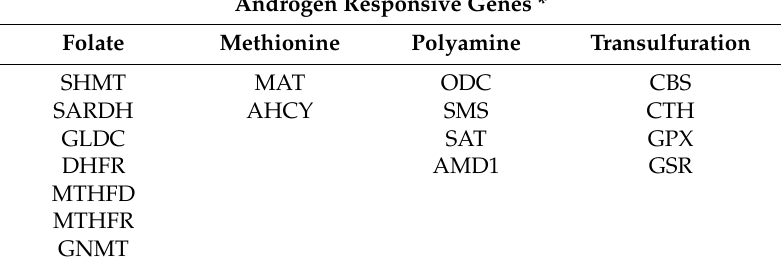
Table 1. Androgen responsive genes of the one carbon metabolism network. * Data from the androgen responsive gene database (available online: http://argdb.fudan.edu.cn/index_info.php). MTHFD: methylenetetrahydrofolate dehydrogenase; SMS: spermine synthase; SAT: spermine/spermidine peroxidase; GSR: glutathione reductase. Other names as in legend of Figures 1 and